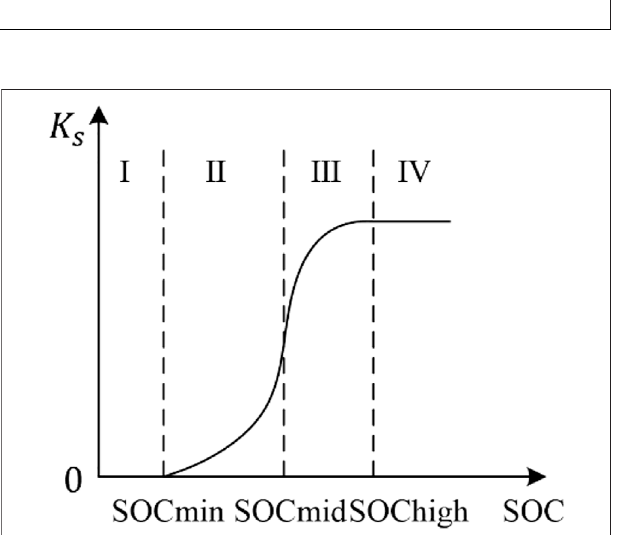
FIGURE 1 | Relationship between the battery depth of discharge and its cycle life.